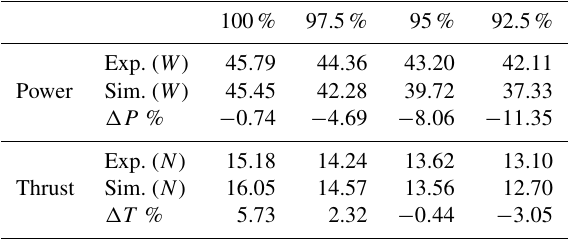
Table 2. Power and thrust at 100%, 97.5%, 95% and 92.5% power